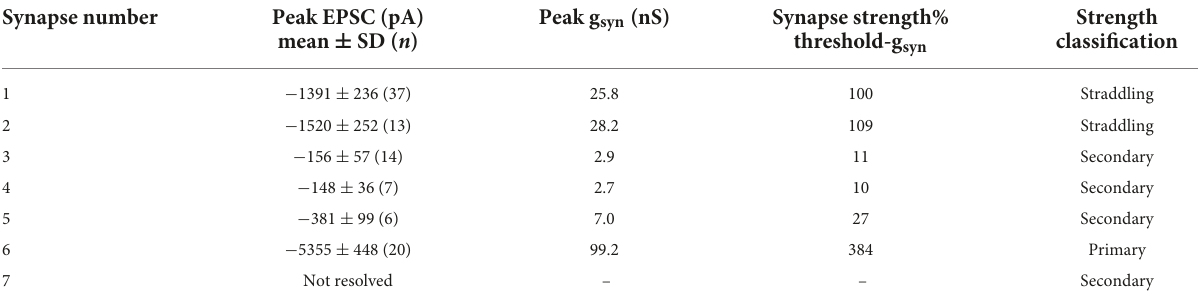
TABLE 1 Strength classification of synapses converging on one